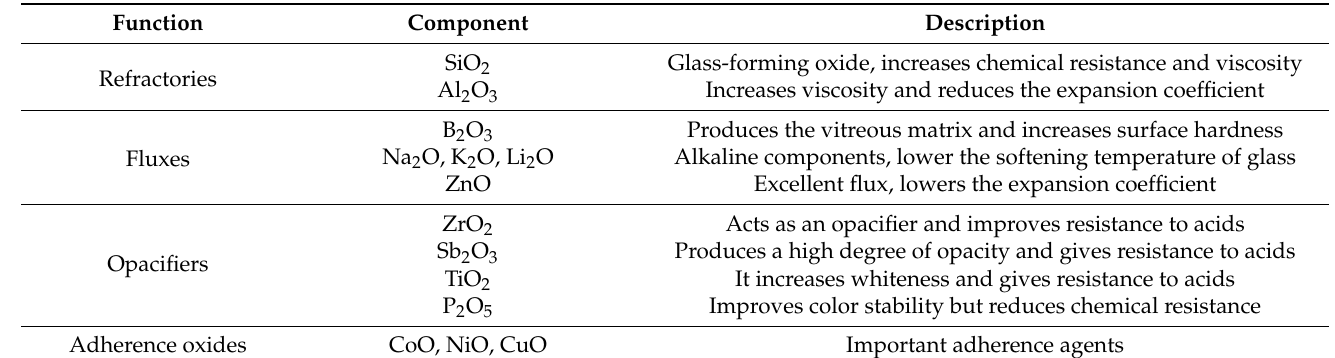
Table 1. Common oxides used in frit